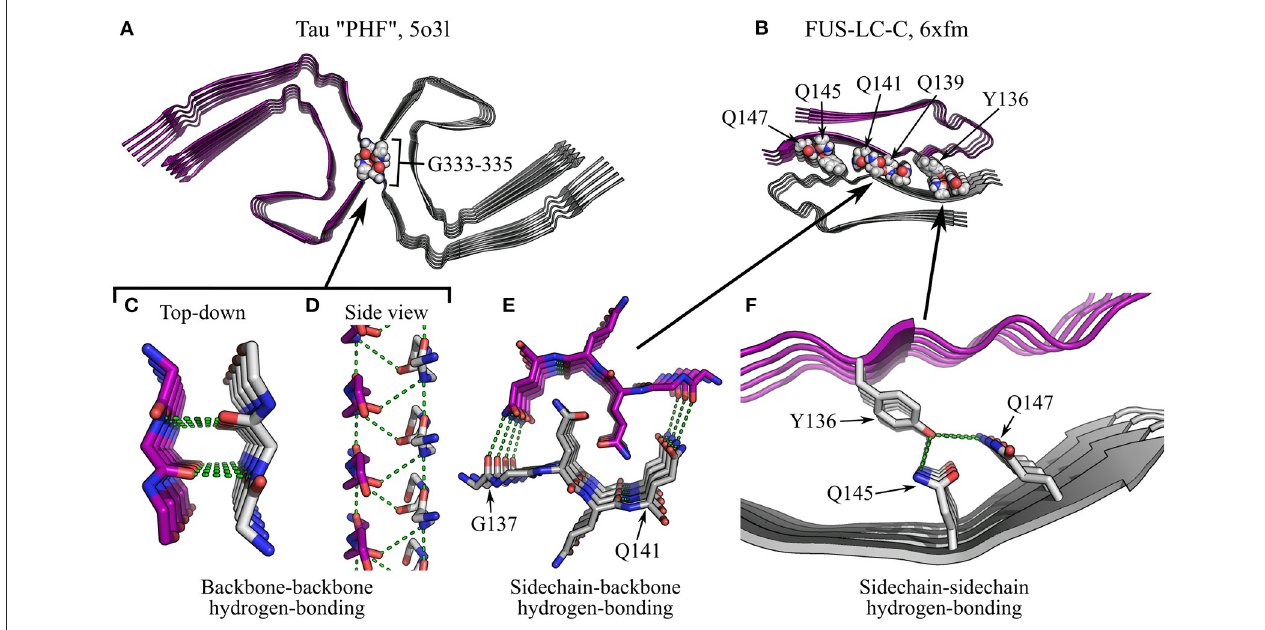
FIGURE 11 | Specific interactions in supra-protofilament assembly (part 2). (A,B) show fibril structures with specific inter-protofilament interactions highlighted: (A) , Tau “PHF” polymorph (Fitzpatrick et al., 2017), with backbone-backbone hydrogen bonding by triglycine repeats; (B) , FUS-LC-C (Lee et al., 2020), with sidechain-backbone hydrogen bonding by interdigitated glutamines, and sidechain-sidechain hydrogen bonding by Y136, Q145, and Q147. The name of the polypeptide is given above each structure, alongside the polymorph in quotes where relevant, and the PDB ID. Structures are shown as ribbon diagrams, with protofilaments colored gray or purple for discrimination. Sidechains of interest are highlighted as spheres, with the color scheme: gray, carbon/hydrogen; red, oxygen; blue, nitrogen. For (B) , missing hydrogens have been modeled in. The same scale is used throughout (A,B) , and is shared with that used in Figures 10A–C . (C–F) show close-up views of the highlighted interactions. In (F) , the structure is shown as a ribbon diagram with the sidechains as sticks, using the same color scheme as before; in (C–E) , both the backbone and sidechains are shown as sticks, with carbons on one protofilament colored purple. For clarity and consistency between structures, hydrogens are not represented with sticks and are thus implicit. Hydrogen bonds are represented by green dashed lines. Note that the zig-zag alternation of polypeptide backbones across the interface in (D) is due to pseudo-2 1 symmetry.